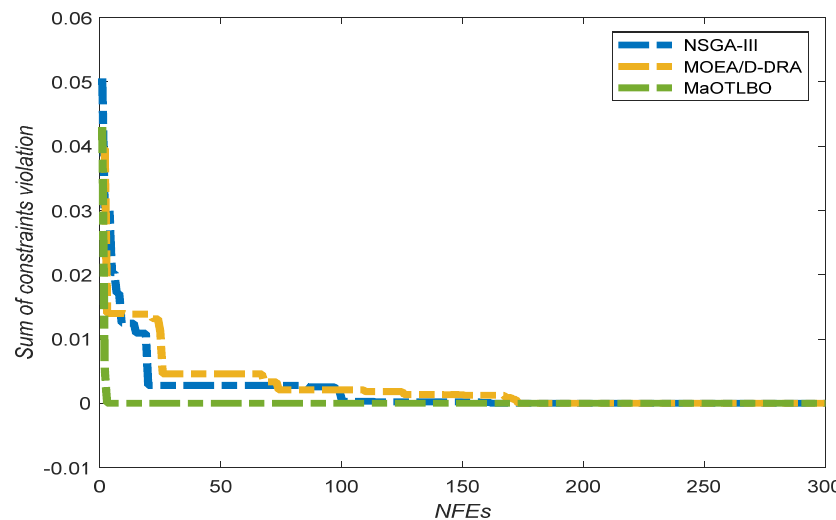
Fig. 10. Sum of constraints violations versus the number of function evaluations curve using MaOTLBO, NSGA-III, and MOEA/D-DRA